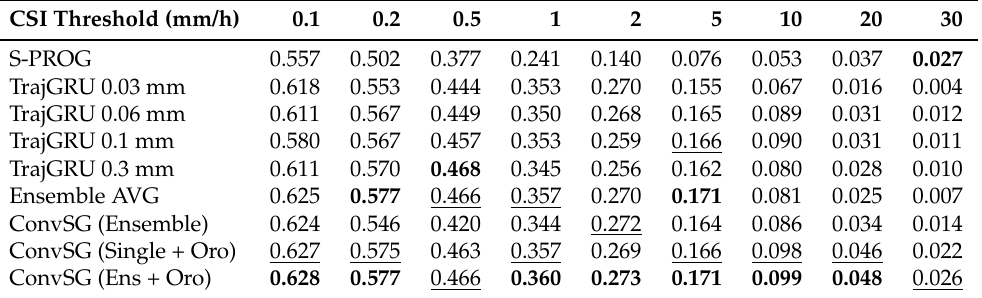
Table 2. CSI forecast skill of the ESG models compared with the ensemble (higher is better). In bold is the best result, the second best is underlined.